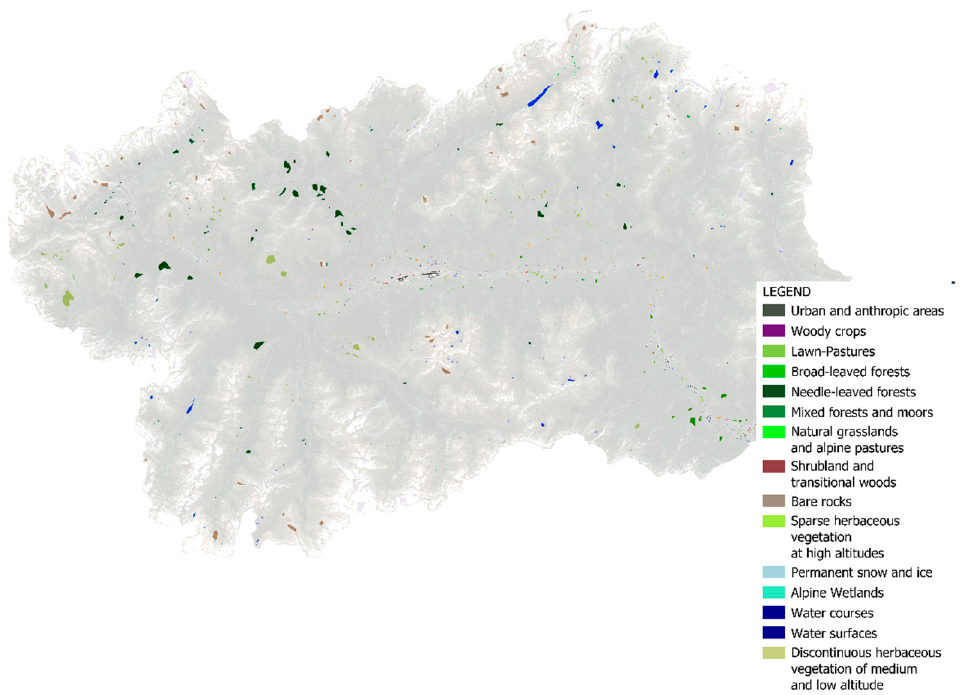
Figure 3. ROIs considering both the training and validation sets.